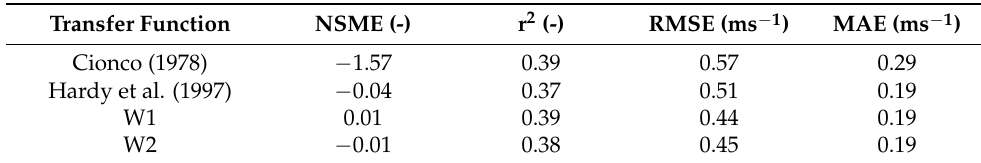
Table 5. Comparison of mean efficiency criteria for wind speed transfer functions. Transfer